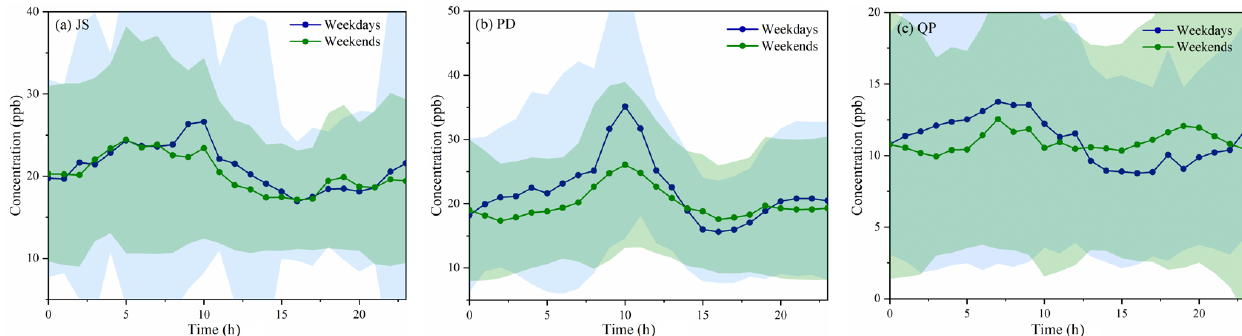
Figure 3. “Weekend effects” of the TVOC concentrations at the sampling sites.